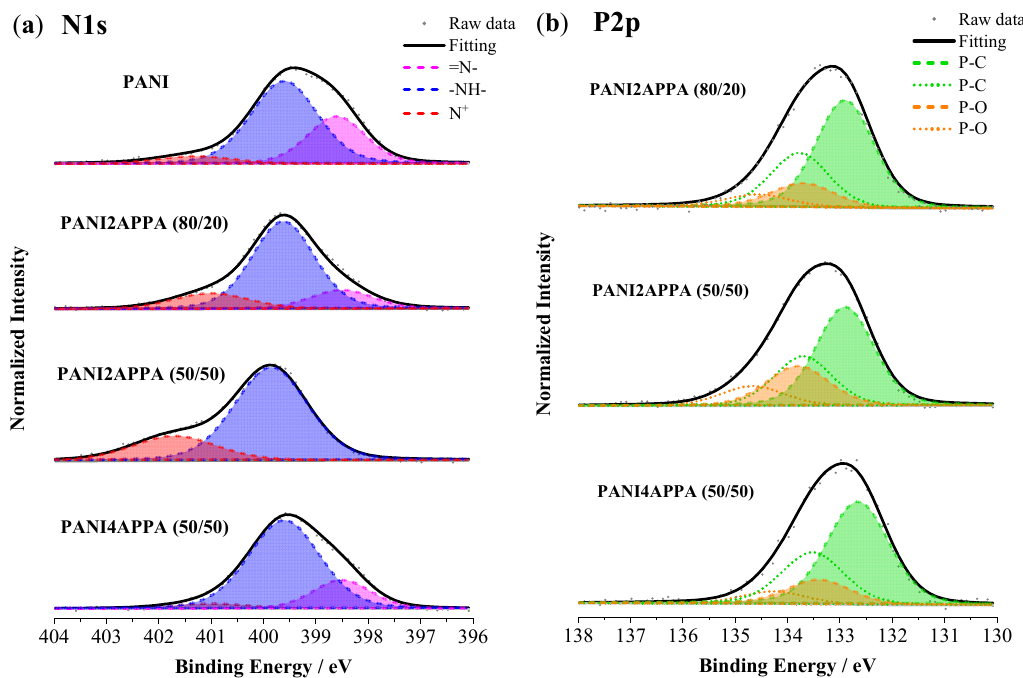
Figure 1. ( a ) N1s and ( b ) P2p spectra of PANI, PANI2APPA feed ratio 80/20 and 50/50, and PANI4APPA feed ratio 50/50.